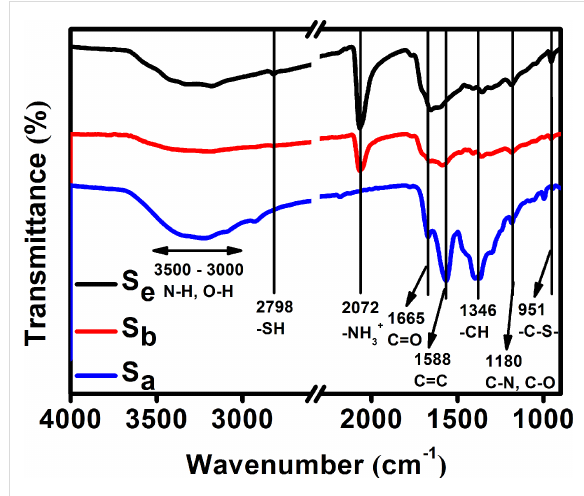
Figure 3: Fourier transform infrared spectra of S a , S b, and S e .